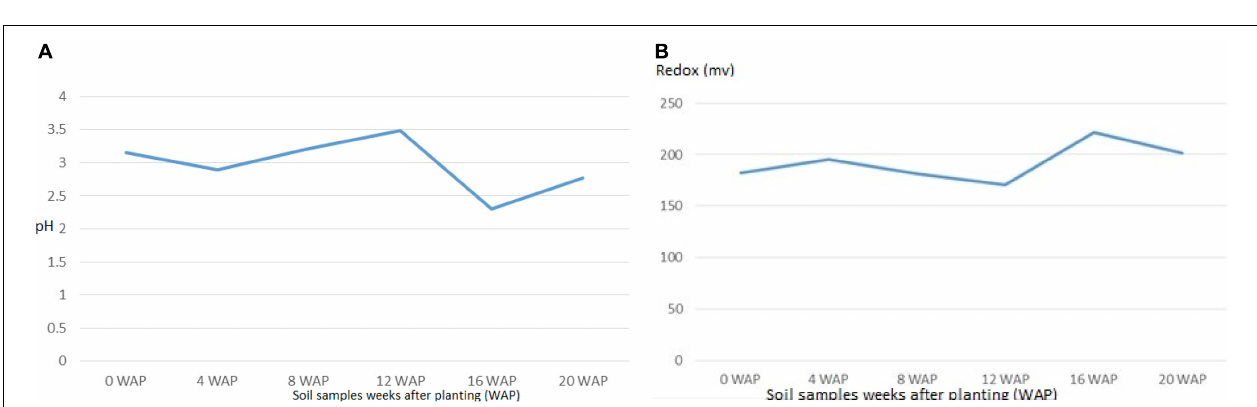
FIGURE 4 | Physical and chemical analysis of soil samples at 8, 12, 16, and 20 WAP. DVL1, DVL2, DVBR1, and DVBR2 are soil samples from 8 WAP (A) , JVL1, JVL2, JVBR1, and JVBR2 are soil samples from 12 WAP (B) , FVL1, FVL2, FVBR1, and FVBR2 are soil samples from 16 WAP (C) , MVL1, MVL2, MVBR1, and MVBR2 are soil samples from 20 WAP (D) , D, December; J, January; F, February; M, March; VL and VBR, variety of Bambara from whose root soil samples were taken.